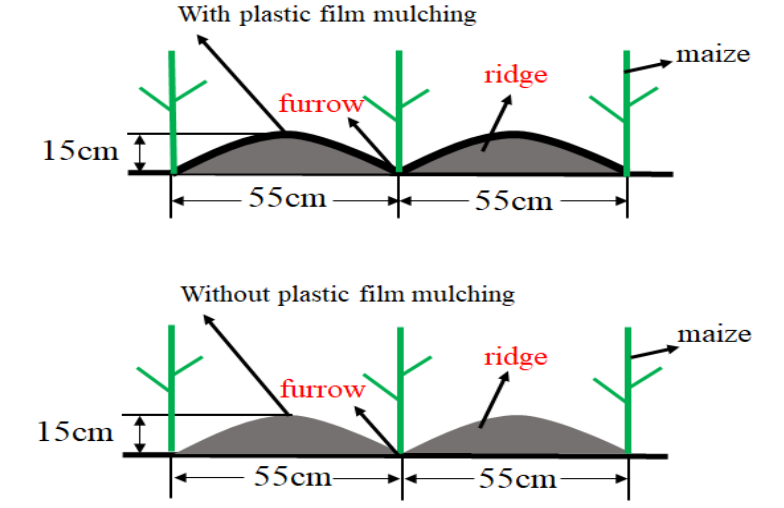
Figure 1. Ridge–furrow with/without full plastic film mulching diagram.